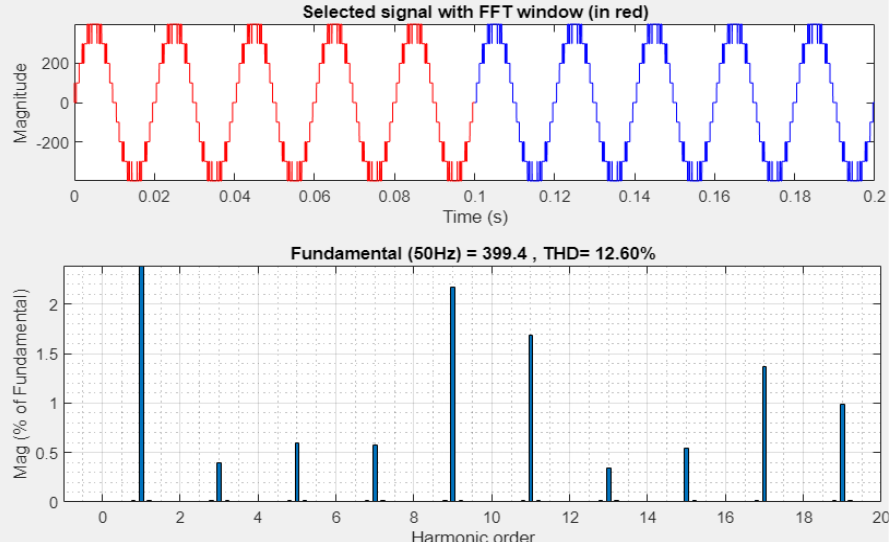
Figure 27. FFT spectrum of the output voltage before filtering.